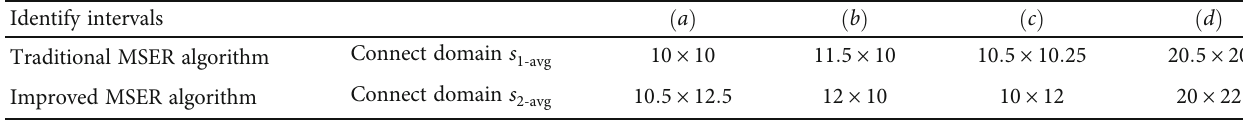
Table 3: Intervals of median connected domains before and after improvement.